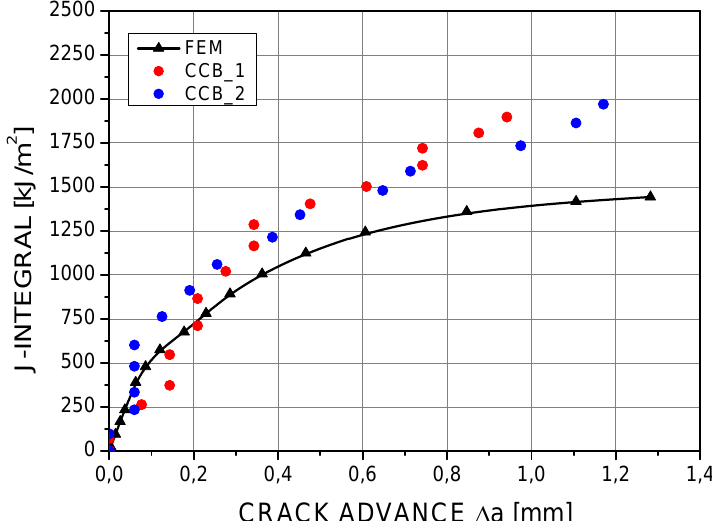
Figure 11: Comparison of calculated crack resistance and crack driving force obtained using unloading compliance values.